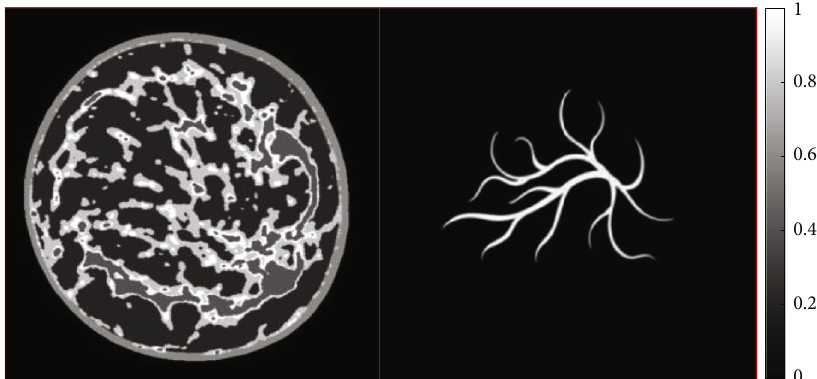
Figure 1: The breast phantom and the blood vessel phantom.